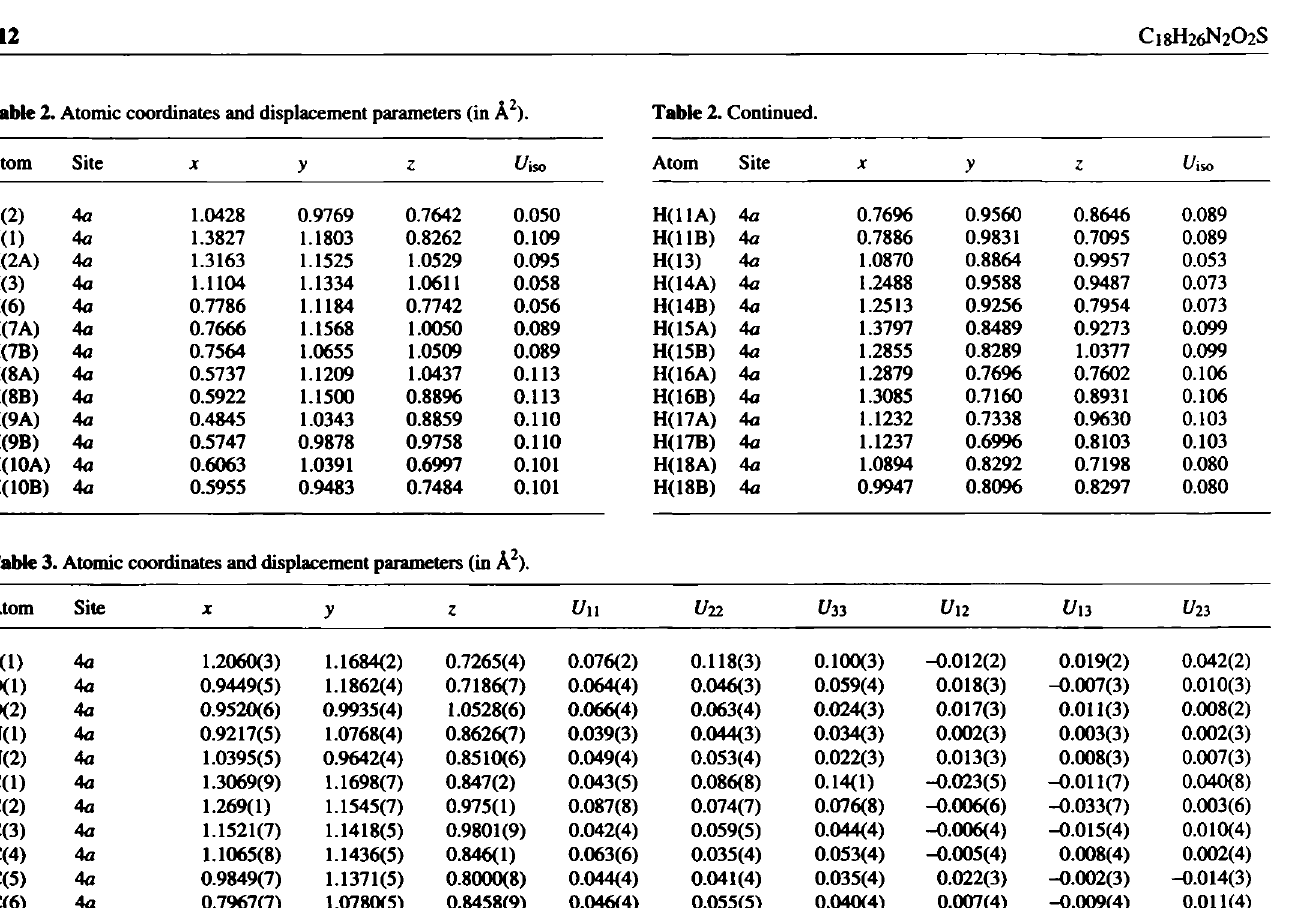
Table 2. Atomic coordinates and displacement parameters (in Â 2 ).